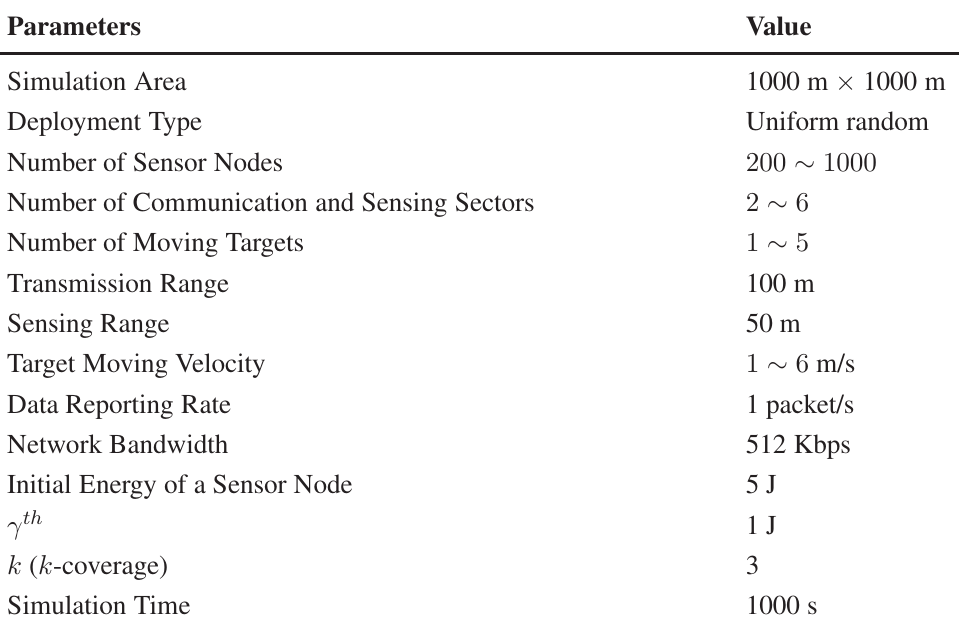
Table 2. Network configuration